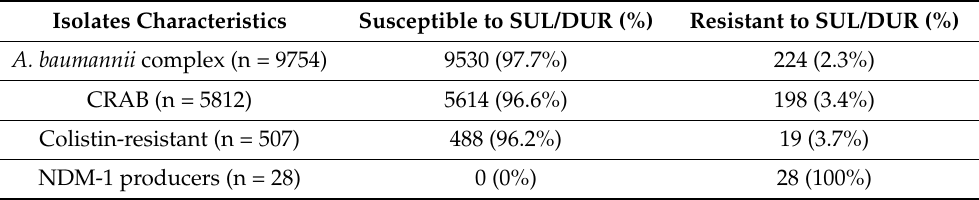
Table 2. Antimicrobial activity of sulbactam/durlobactam against Acinetobacter tested